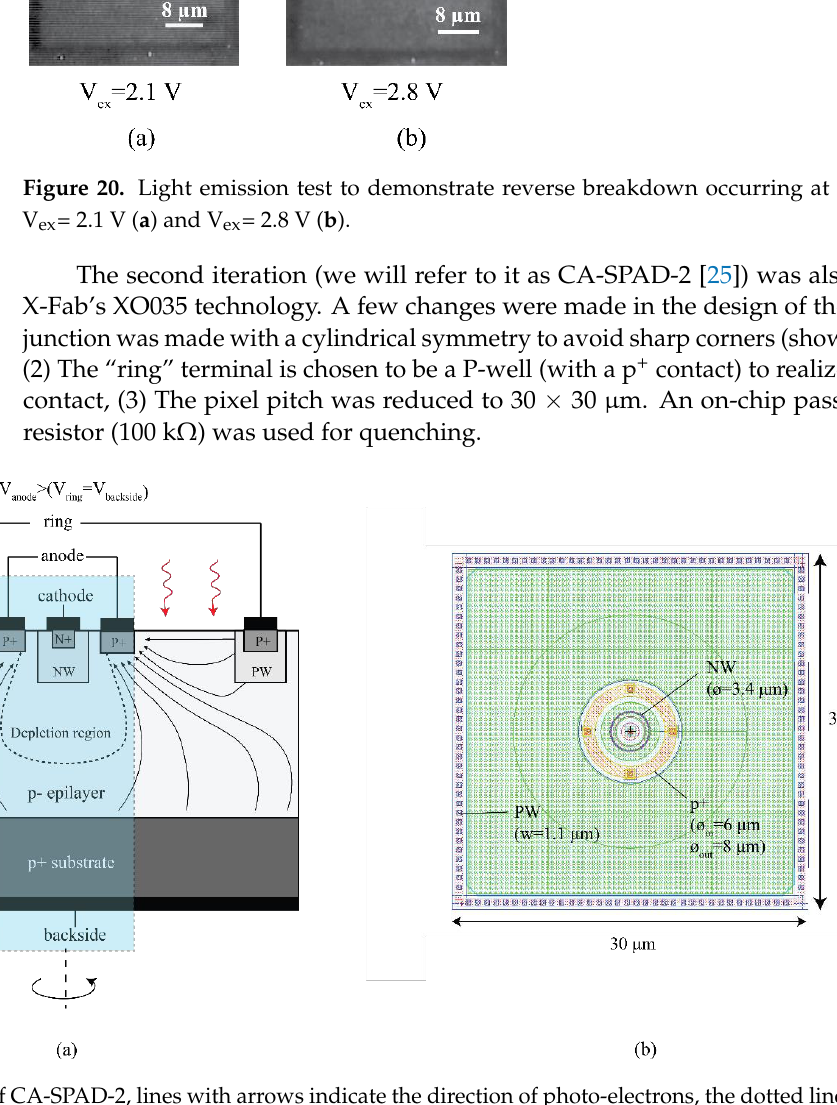
Figure 19. Cross section of CA-SPAD-1, lines with arrows indicate the direction of photo-electrons, dotted line represents the boundary of the depletion region ( a ) and top-view of the layout of CA-SPAD-1 with dimensions indicated ( b ).